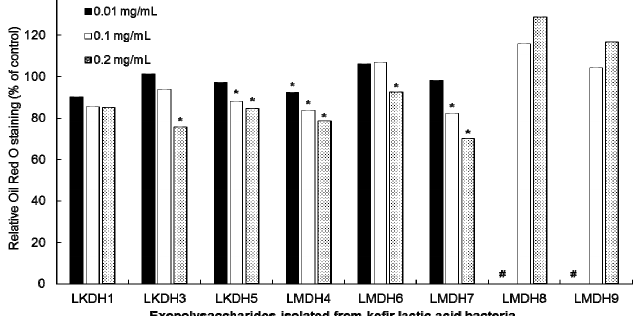
Figure 3. Inhibitory effects of cellular exopolysaccharide (EPS)s of heat-killed kefir lactic acid bacteria with increasing concentrations (0.01, 0.1, 0.2 mg/mL) on relative Oil red O staining content in 3T3-L1 adipocytes after differentiation (day 6). The cells differentiated in the presence of the heat-killed kefir LAB (HLAB) for 6 days after confluence. Values of the intracellular Oil red O staining of the treated cells are presented as percentages relative to the values of the untreated control. Data are expressed as mean ± SEM, * indicates a significant difference ( p < 0.05) compared to control, # data were not measured.